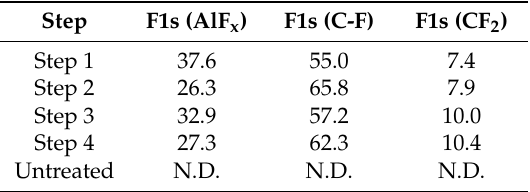
Table 5. XPS spectra analysis of fluorine bonding ratio (%).